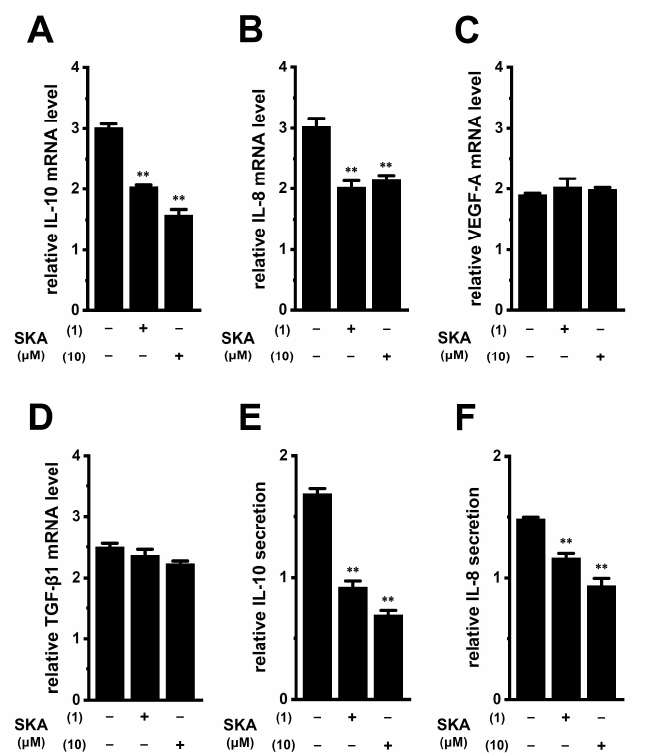
Figure 10. Effects of treatment with SKA-121 on expression levels of IL-10, IL-8, VEGF-A, and TGF-β1 transcripts and IL-10 and IL-8 secretion in human prostate cancer PC-3 cell-cultured medium-treated THP-1-derived M 2 macrophages. ( A – D ): Real-time PCR examination of IL-10 ( A ), IL-8 ( B ), VEGF-A ( C ), and TGF-β1 ( D ) expression in PC-3 media-treated THP-1-derived M 2 macrophages treated (+) or untreated (-) with 1 or 10 μM SKA-121 for 24 h. Relative mRNA expression in the group untreated with PC-3 medium is expressed as 1.0 (n = 4 for each). ( E , F ): Quantitative detection of IL-10 ( E ) and IL-8 ( F ) secretion by an ELISA assay in THP-1-derived M 2 macrophages treated or untreated with SKA-121. Relative secretion in the group untreated with PC-3 medium is expressed as 1.0 (n = 4 for each). **: p < 0.01 vs. the vehicle control (−/−).